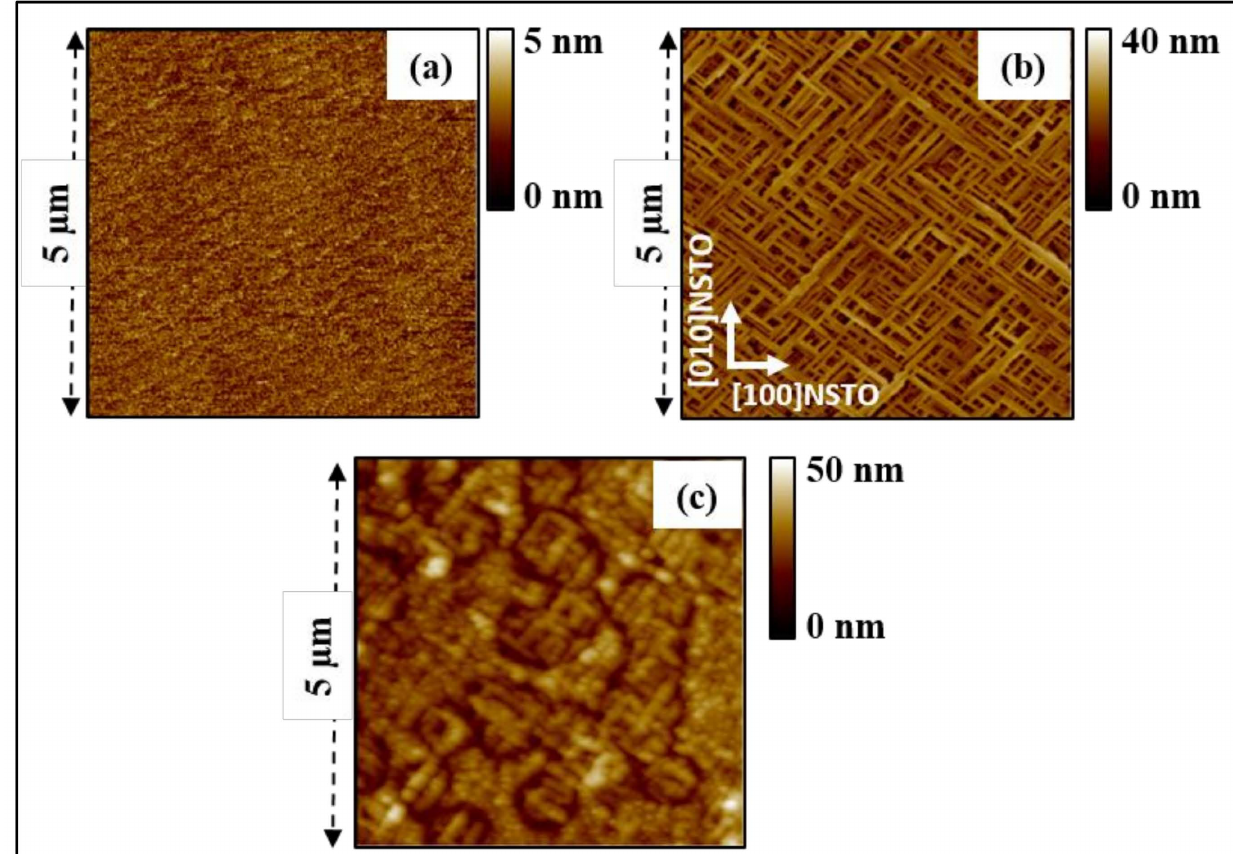
Figure 1. AFM images representing the topography of the surface of ( a ) NSTO (001) substrate; ( b ) of BaFO thin film deposited on top of a NSTO substrate and annealed at 850 ◦ C while ( c ) shows the surface topography of the TTB-Eu/BaFO/NSTO heterostructure after annealing at 800 ◦